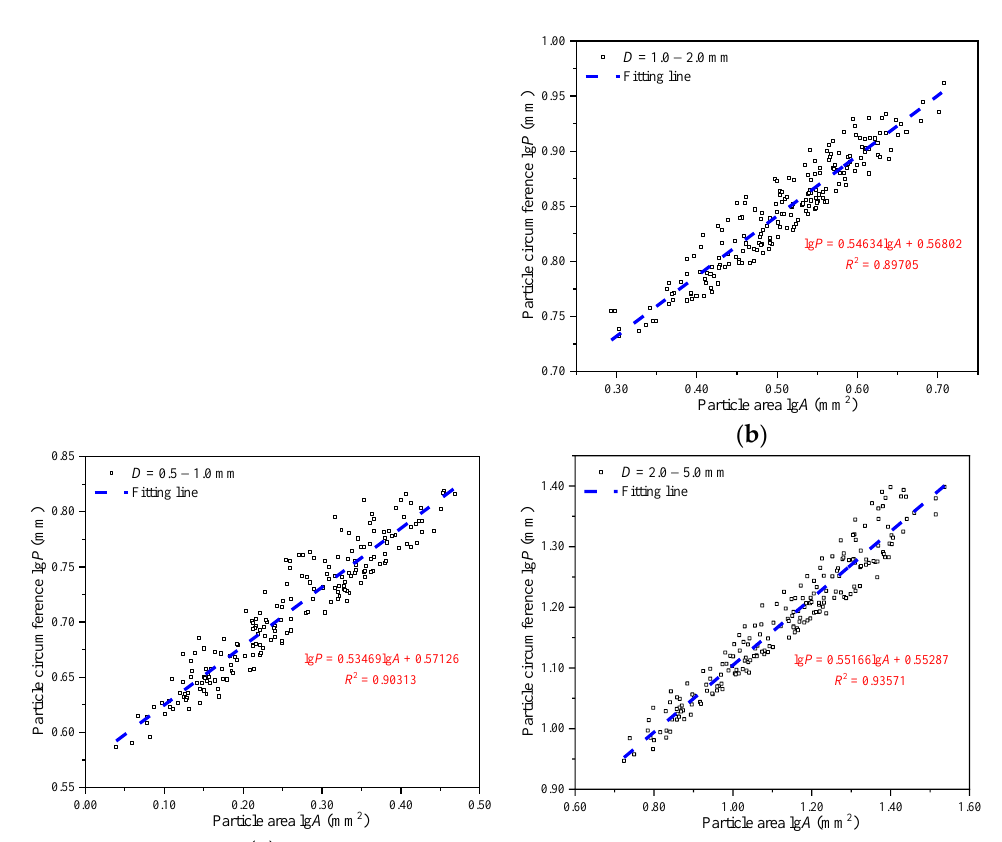
Figure 11. Coral sand with different particle sizes: ( a ) D = 0.5–1.0 mm, ( b ) D = 1.0–2.0 mm, and ( c ) D = 2.0–5.0 mm.